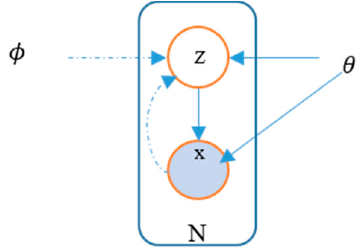
Figure 35. Variational Auto-Encoder.